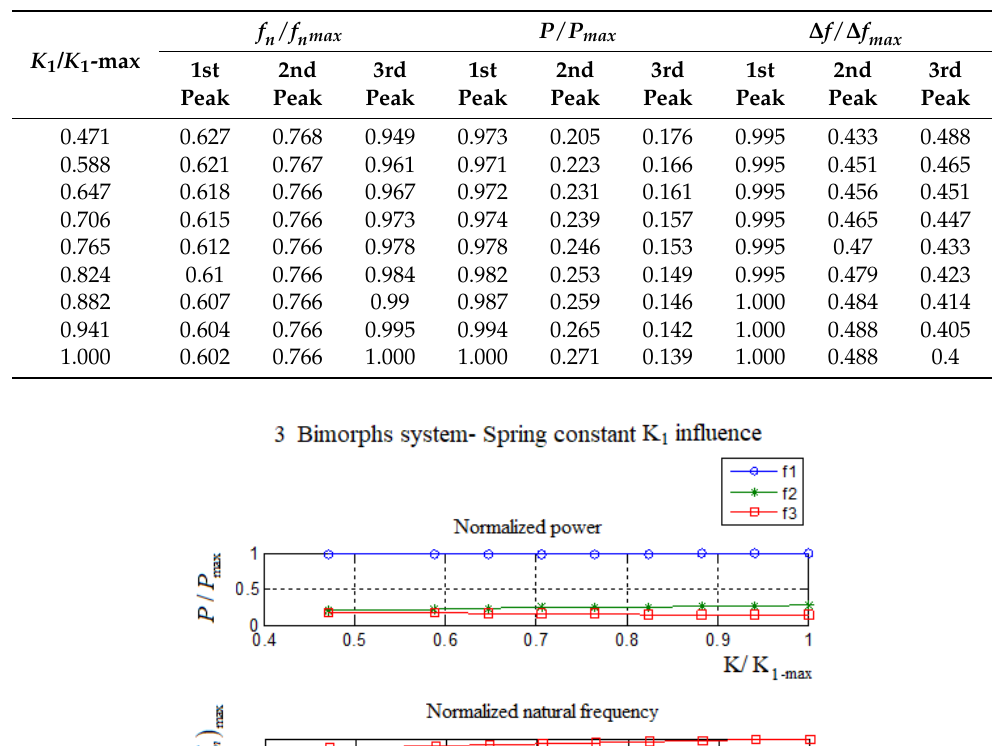
Table A10. Three bimorphs system—influence of K 1 spring constant connected to the external lighter mass normalized values.